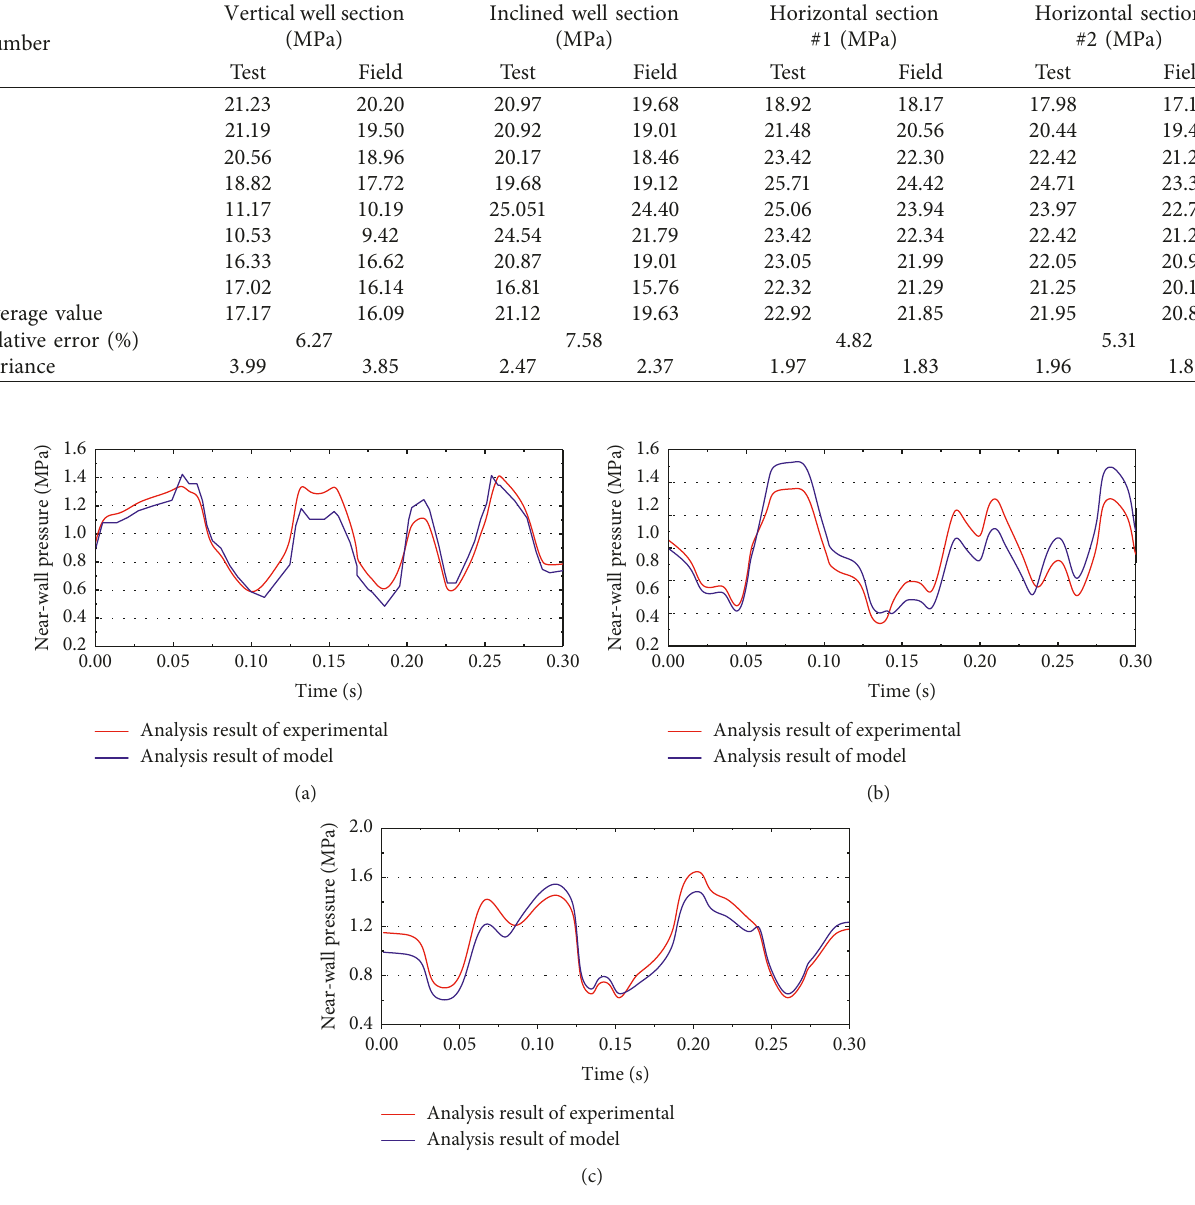
Figure 11: Variation of pressure in the wall of the pipe with time during gas injection. (a) Vertical well section. (b) Inclined well section. (c) Horizontal section.